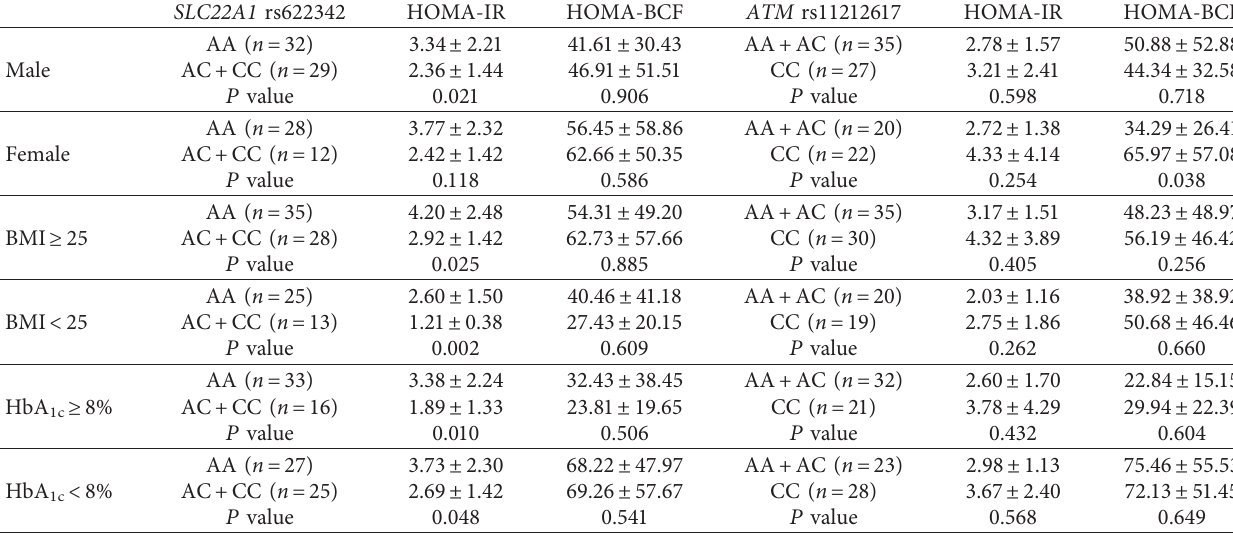
Table 3: The distributions of HOMA-IR and HOMA-BCF among the genotypes of SLC22A1 rs622342 and ATM rs11212617 according to gender, BMI, and HbA 1c